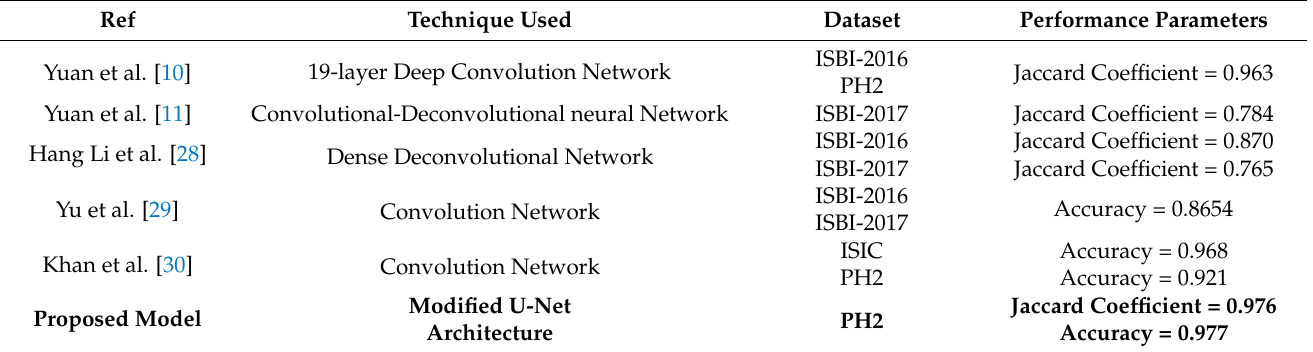
Table 5. Comparison of the Proposed Model with State-of-the-Art